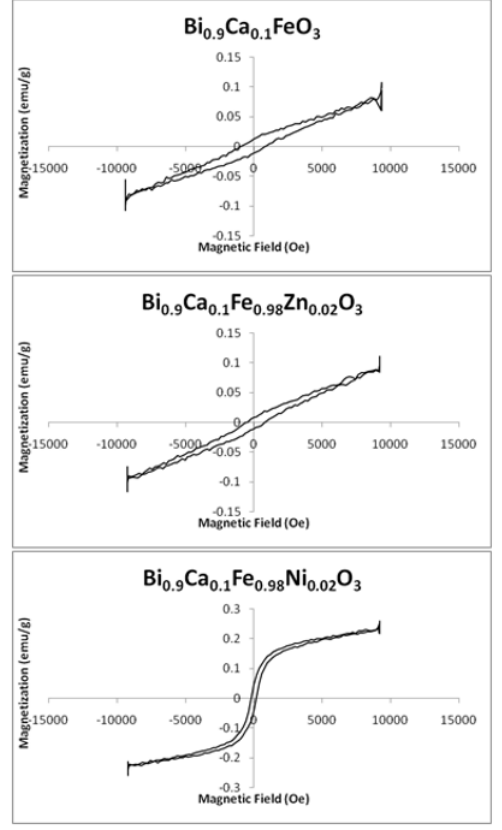
Fig. 3. The hysteresis loops of the Ca-doped compounds